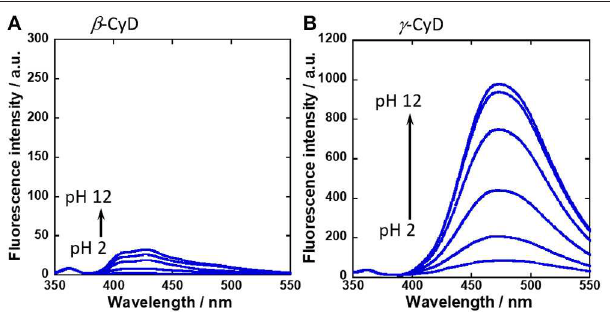
FIGURE 2 | Fluorescence spectral changes of (A) 1 / β -CyD complex with glucose and (B) 1 / γ -CyD complex with glucose in 2% DMSO − 98% water (v/v) with various pH. [ 1 ] = 10 µ M, [CyD] = 5mM, [glucose] = 30mM, [NaCl] = 100mM, [phosphate buffer] = 10mM, λ ex = 323nm.